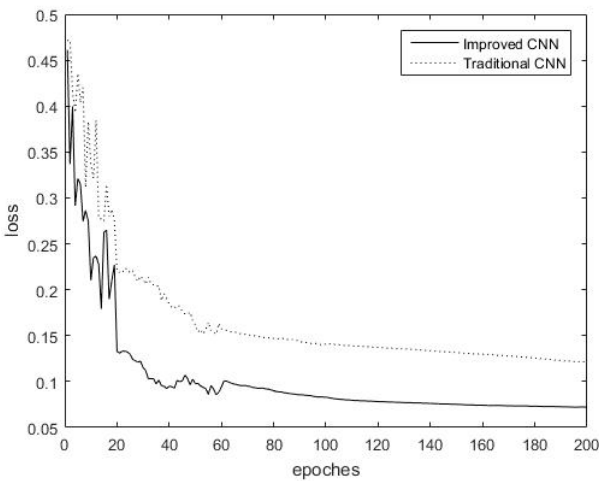
Figure 9. Training error of traditional CNN and maximum overlap pooling CNN iteration in the Salinas dataset.